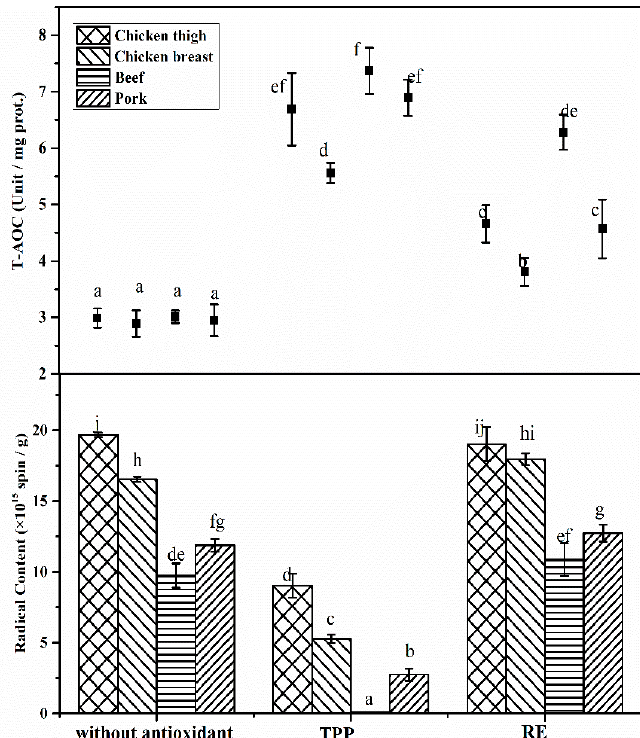
Figure 3. Index of radical formation and total antioxidant capacity (T-AOC) in roasted chicken thigh, chicken breast, pork and beef with or without the addition of antioxidants. Means with different letters are significantly different ( p < 0.05).